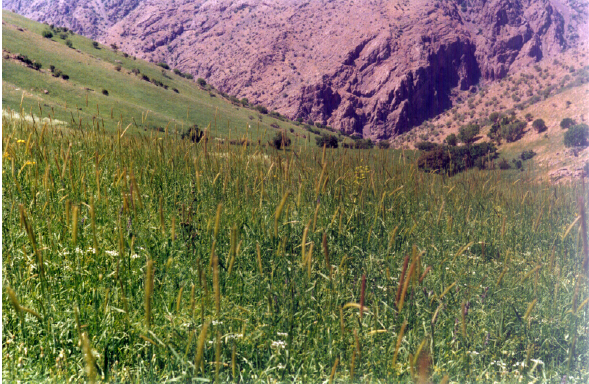
Fig. 13. Hordeum-Medicago